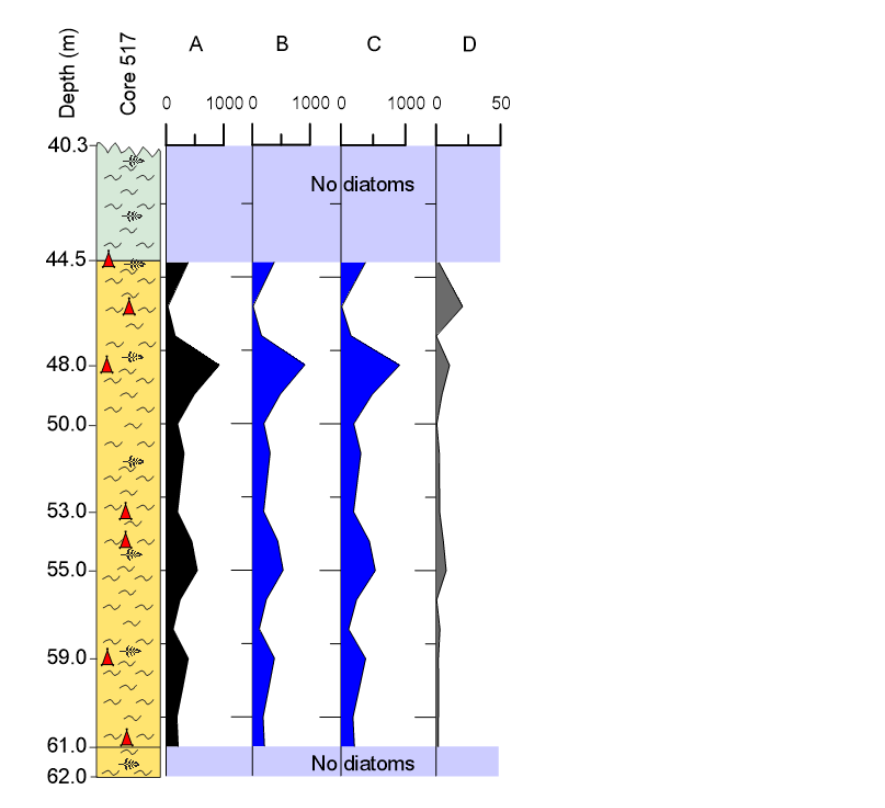
Figure 4. Quantitative distribution of Alveolophora antiqua in core 517: A—the number of diatoms (million valves/gram); B—the number of planktonic diatoms; C—the number of A. antiqua ; D—the number of benthic diatoms. Triangles in the lithological column show sampling depths for palynological analysis.